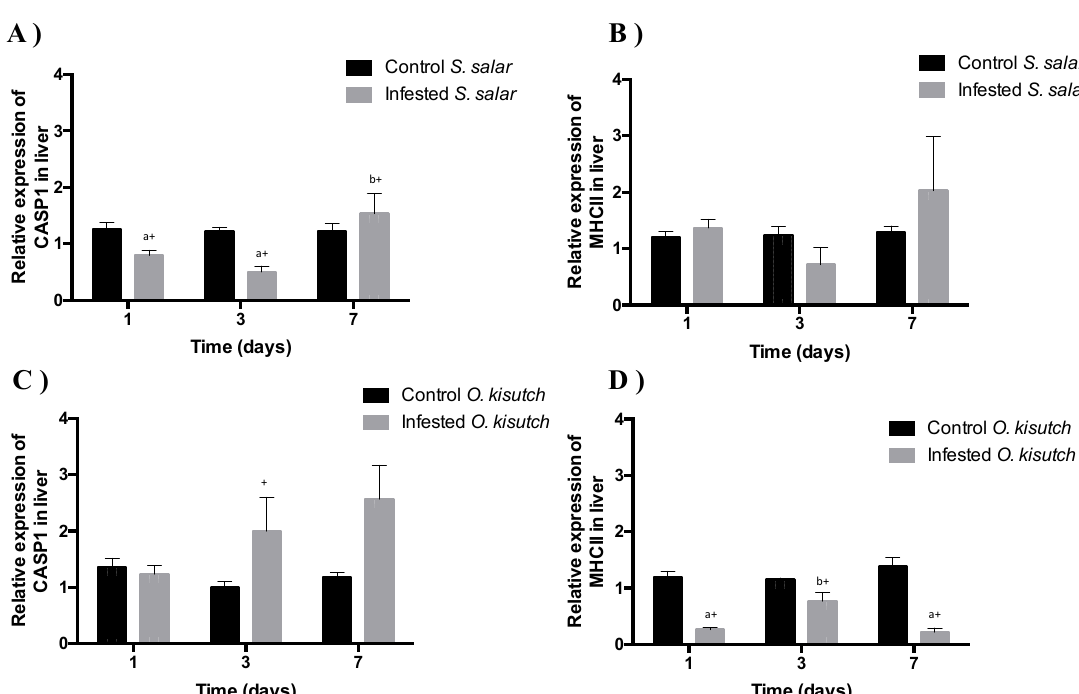
Figure 4. Relative expression of caspase-1 and MHCII transcripts in Salmo salar and O. kitsuch liver infested with C. rogercresseyi . Relative mRNA expression of caspase-1 in liver at 1, 3, and 7 dpi ( A , C ). Relative mRNA expression of MHCII in the liver at 1, 3, and 7 dpi ( B , D ). The 18s gene was used as a reference gene to calibrate the cDNA template for all samples. Bars represent the mean values (± S.E.) of 20 samples. Letters (a,b,c) represent statistical differences within the same group over time. The + symbol represents statistical differences at the same time-point between groups (i.e., infested vs. control). Statistical differences were established by two-way ANOVA ( p < 0.05).